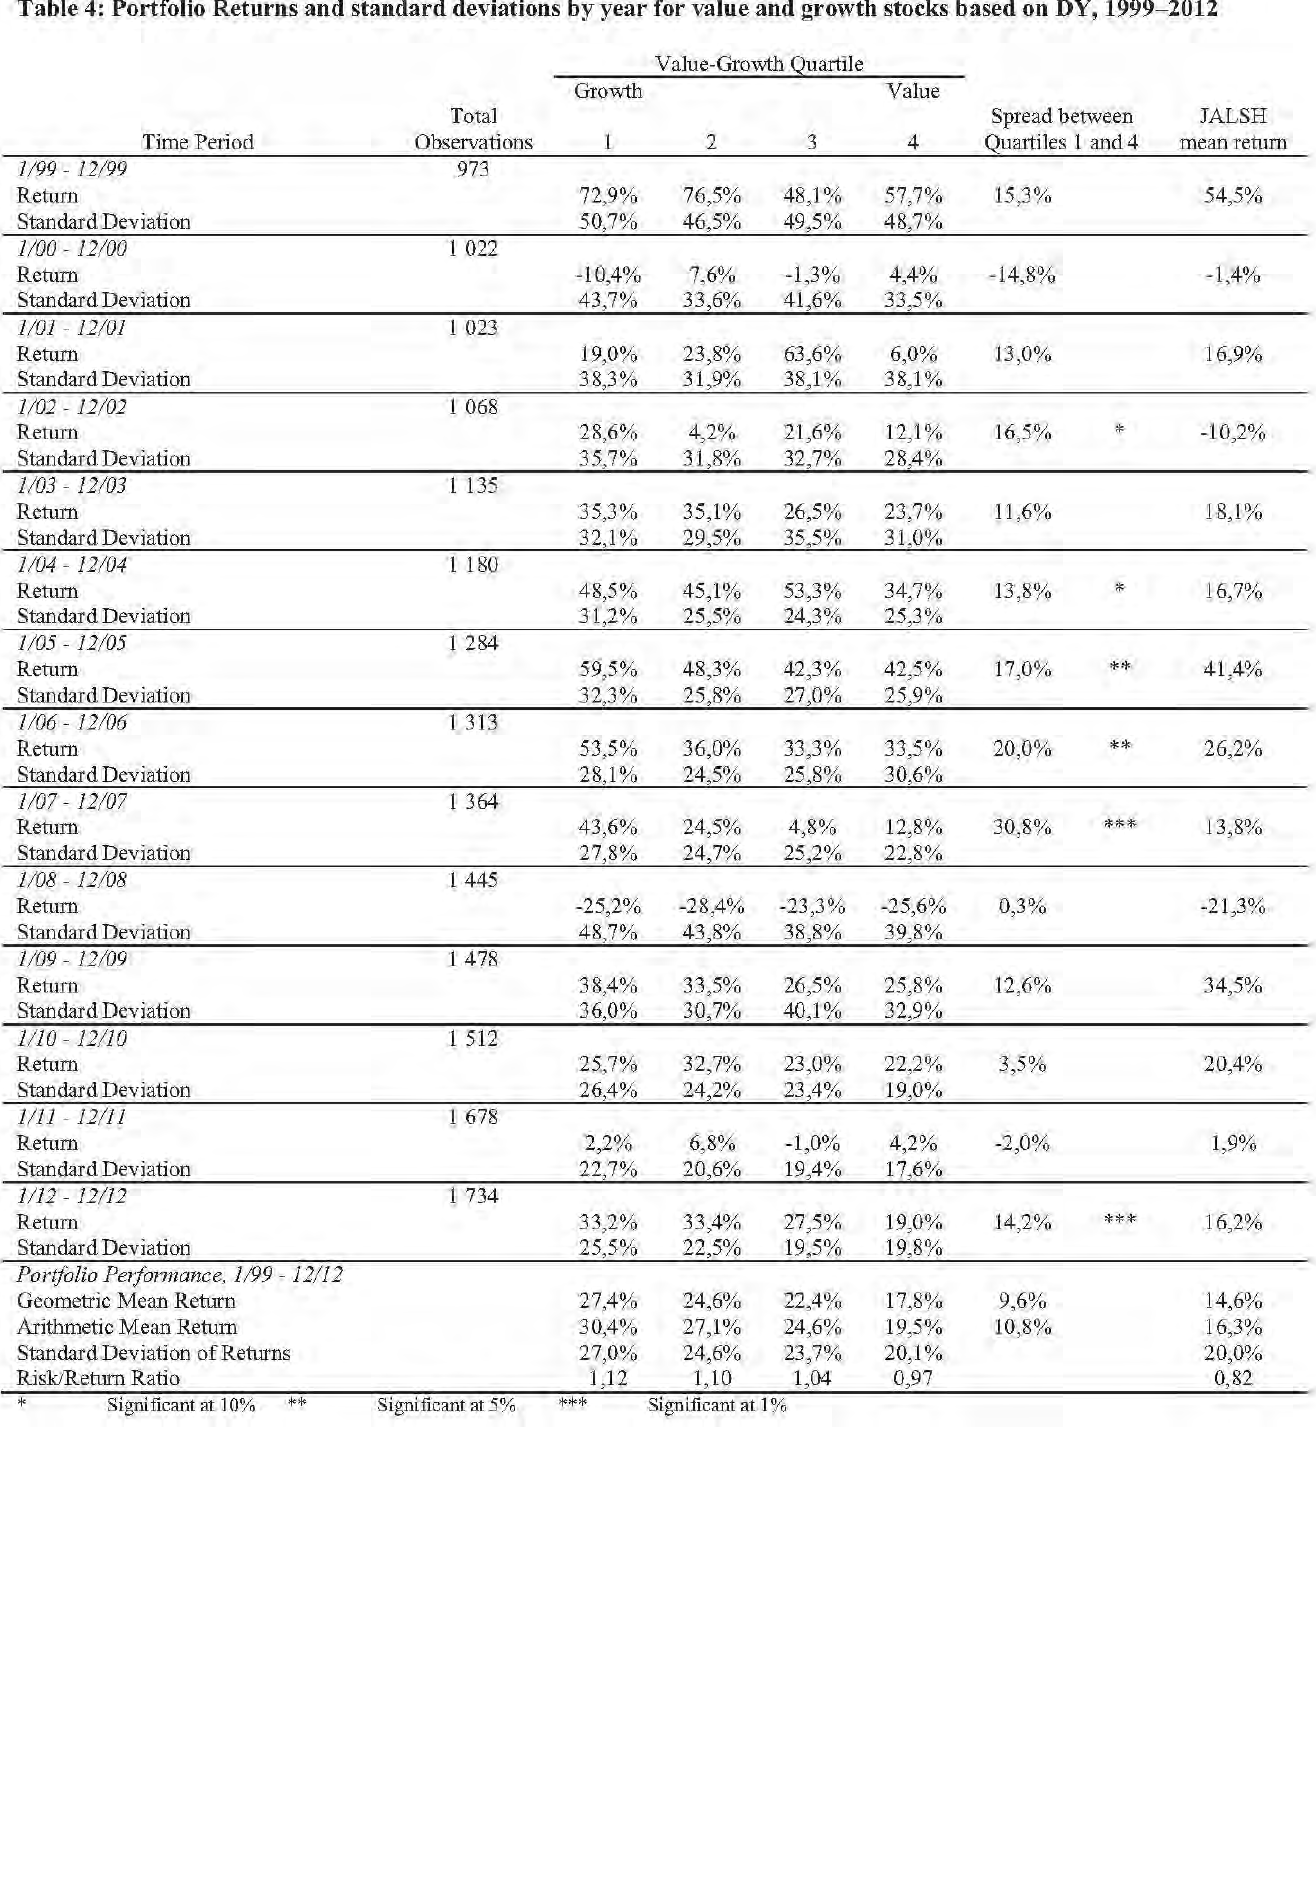
Table 4: Portfolio Returns and standard deviations by year for value and growth stocks based on DY, 1999-2012 Value-Growth